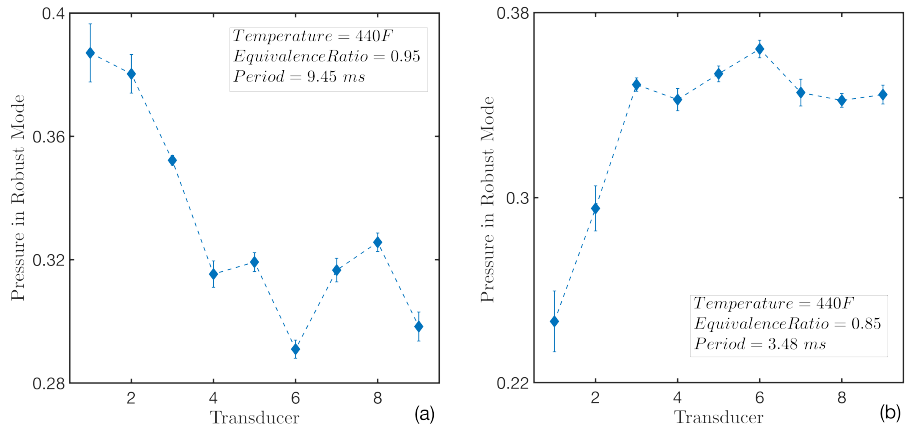
Figure 8. ( a ) Symmetric robust mode: Projections of the single robust mode at φ = 0.95. The x -axis is the transducer number, and the y -axis the magnitude of the robust mode at the site. Note that values of the mode on sites 4, 5, and 6 are nearly identical to those at sites 7, 8, and 9. Pairs of transducers (4, 7), (5, 8), and (6, 9) are at identical axis locations, thus indicating that the robust mode represents a symmetric flow constituent. ( b ) Asymmetric robust mode: One robust modes of the flow at φ = 0.85. Note that it does not have the symmetry between the values at transducer pairs (4, 7), (5, 8) and (6, 9) seen in the mode of ( a